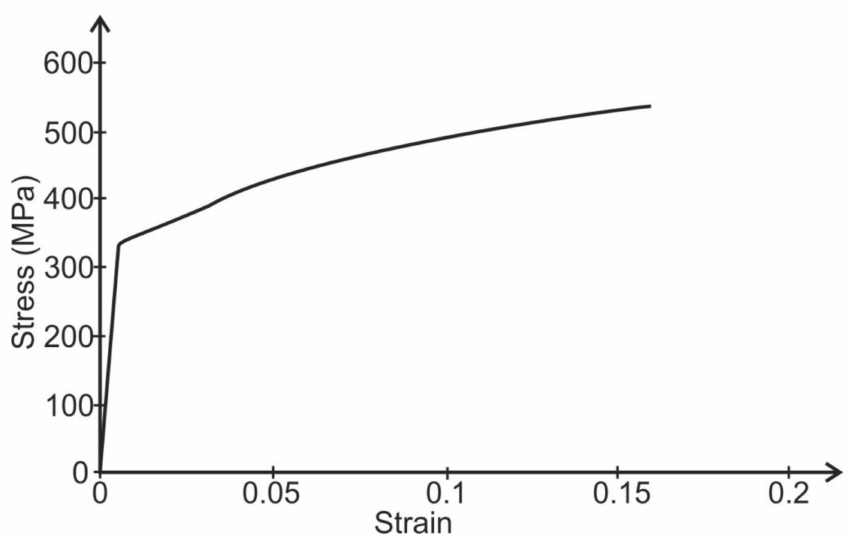
Figure 8. The stress–strain curve for 2024T4 alloy (tensile curve with the considering of specimen cross-section area